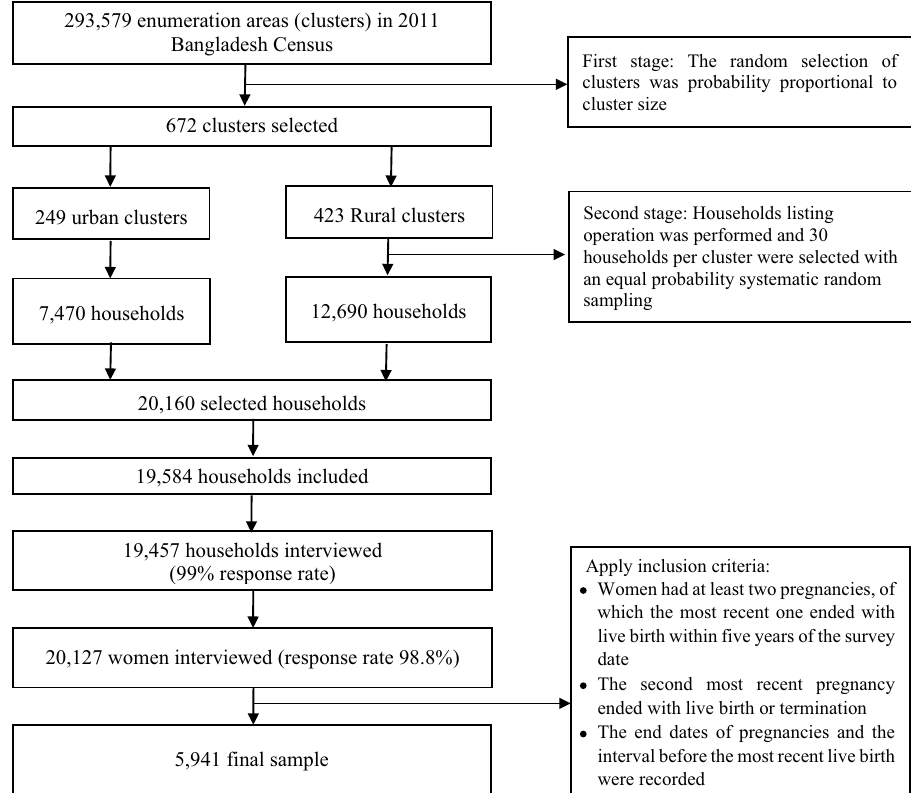
Figure 1. Flow chart of the study participants selected from the Bangladesh Demographic and Health Survey,